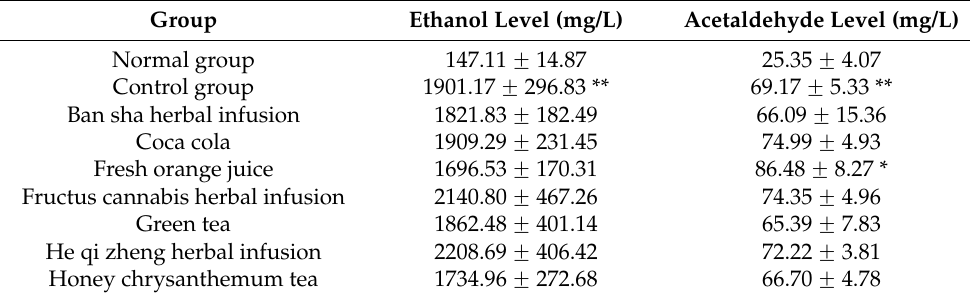
Table 1. Effects of the 20 selected beverages on ethanol and acetaldehyde level in